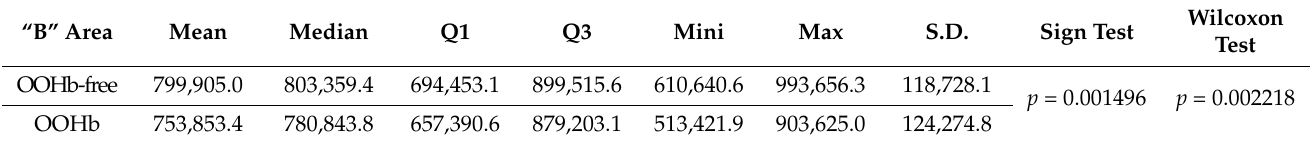
Figure 11. The view occlusion extremum (red) at A2S2 measurement point. From this observer location, the OOHb crate the infrastructure wall decreasing perceived landscape openness and blocking the city landmarks views (the Lublin Castle and the Old Town in the background). Table 4. The area “B” VVV statistical significance test results along with basic statistic summary. “B” Area